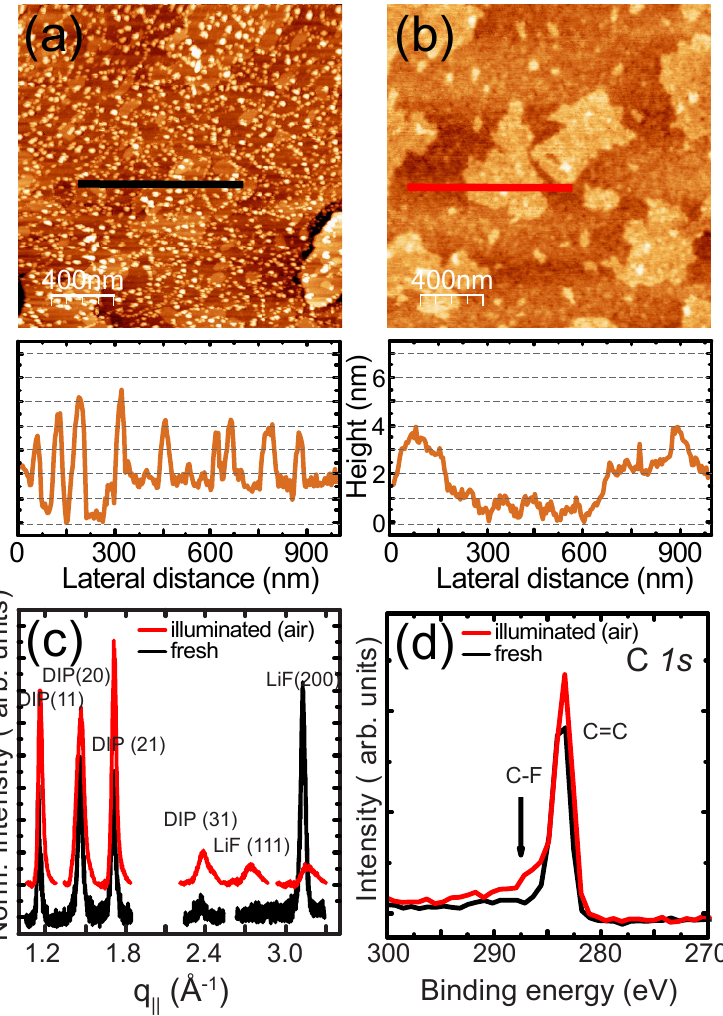
Figure 3. AFM micrographs of the surface morphology of the LiF/DIP bilayer configuration ( a ) be- fore and ( b ) after radiation damage in air and helium atmospheres. The line profiles underneath correspond to the line shown in the AFM micrographs. ( c ) The grazing incidence X-ray diffraction data of pristine and irradiated bilayer films of LiF/DIP/SiO 2 with observed features assigned to the DIP and LiF crystal lattice planes. The DIP structure is unchanged, whereas the LiF appears to become less textured, with an emerging feature assigned to the { 111 } planes. The data are normalized to the highest peak and offset to allow a comparison of the